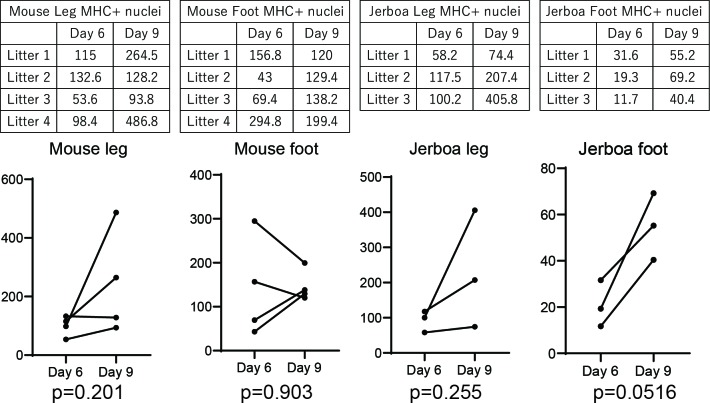
Persistence of differentiated muscle cells in culture after loss in vivo.Myoblasts and myocytes were isolated from leg and foot muscles of P1 mouse and jerboa and differentiated in culture for 6 days and 9 days. The number of nuclei within MHC-positive cells found in 10 microscopic fields of replica-plated cultures were averaged and represented in graphs and tables. p-Values were calculated using paired t-test for replicated wells. None of the experimental groups showed a statistically significant difference in the number of nuclei in Myosin-positive cells between Day 6 and Day 9 of culture.